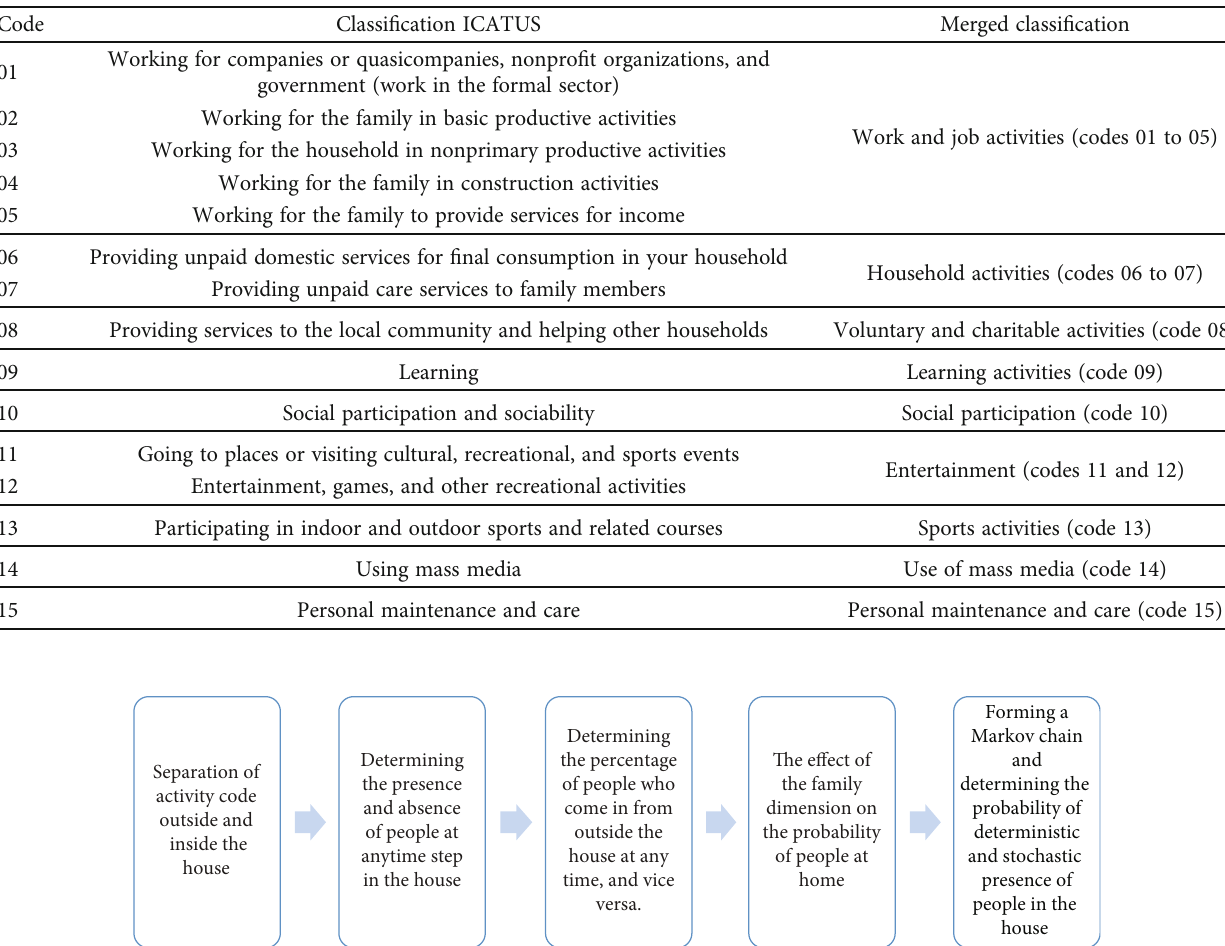
Table 6: Code of activities and its classi fi cation into di ff erent groups.